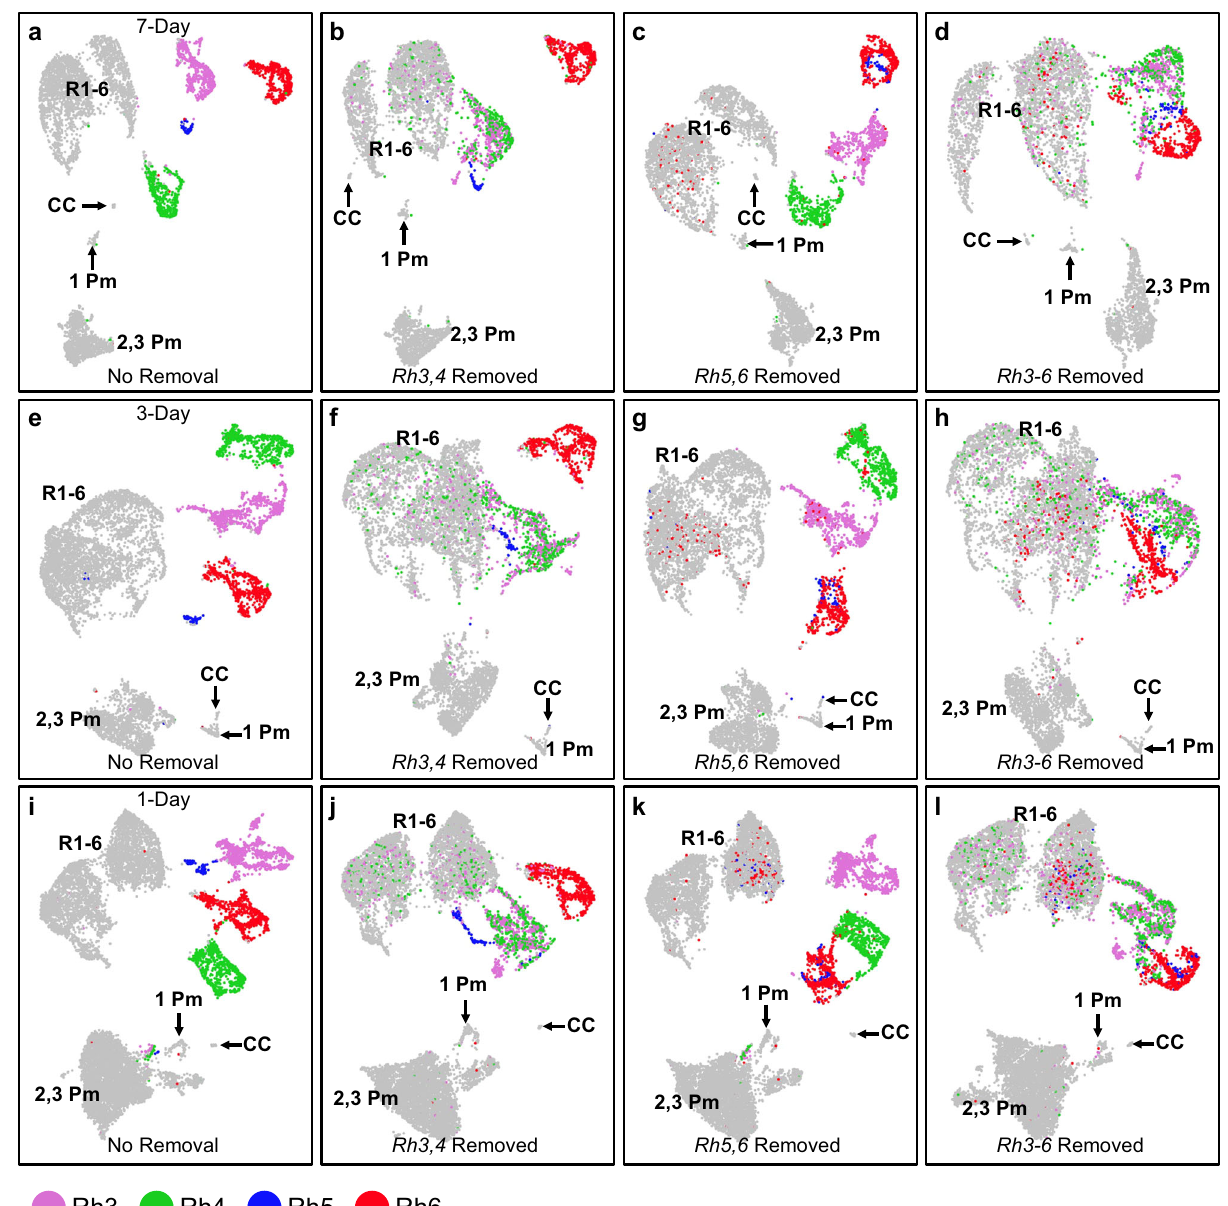
Fig. 7 Rh3 , Rh4 , Rh5 , and Rh6 are major contributors to the clustering of R7 and R8 cells. a UMAP clustering of 7-day-old adult eyes where R7 and R8 cells are shown as four distinct clusters expressing either Rh3 , Rh4 , Rh5 , or Rh6 . b – d UMAP clustering of 7-day-old adult eyes where Rh3/4 counts data ( b ), Rh5/6 counts data ( c ), or Rh3-6 counts data ( d ) were removed from clustering. e UMAP clustering of 3-day-old adult eyes. f – h UMAP clustering of 3-day- old adult eyes where Rh3/4 counts data ( f ), Rh5/6 counts data ( g ), or Rh3-6 counts data ( h ) were removed from clustering. i UMAP clustering of 1-day-old adult eyes. j – l UMAP clustering of 1-day-old adult eyes where Rh3/4 counts data ( j ), Rh5/6 counts data ( k ), or Rh3-6 counts data ( l ) were removed from clustering. Only R7 and R8s were colored for clarity. Gray cell cluster identities were labeled: R1-6 are R1-6 photoreceptors; CC are cone cells; 1 Pm are primary pigment cells; 2,3 Pm are secondary and tertiary pigment